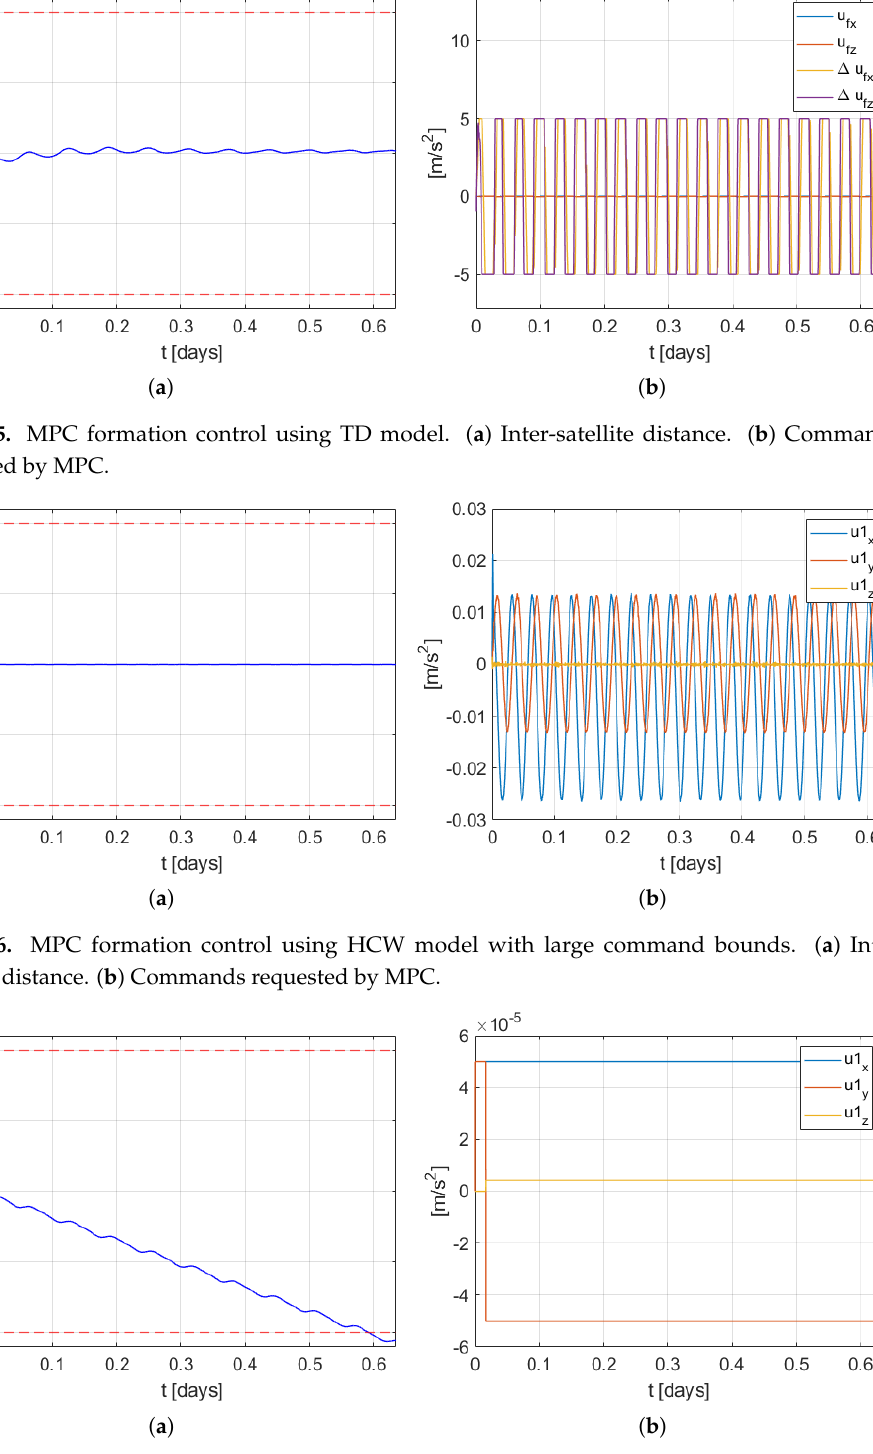
Figure 7. MPC formation control using HCW model with small command bounds. ( a ) Inter- satellite distance. ( b ) Commands requested by